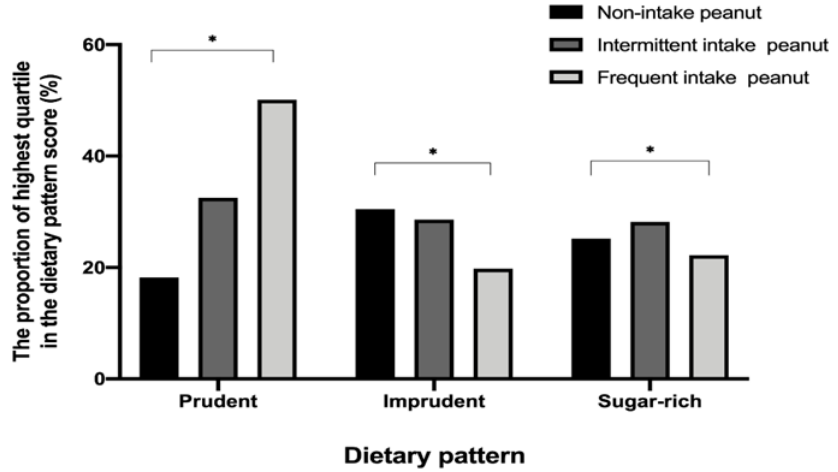
Figure 3. The weighted proportion of the highest quartile of dietary pattern score by peanut intake groups. Study subjects who rarely consumed peanuts, who consumed peanuts 0.25 to 4 times per week, and who consumed peanuts 0.7 to 3 times per day were classified into a non-intake group, an intermittent intake group, and a frequent intake group, respectively. * p < 0.05 .